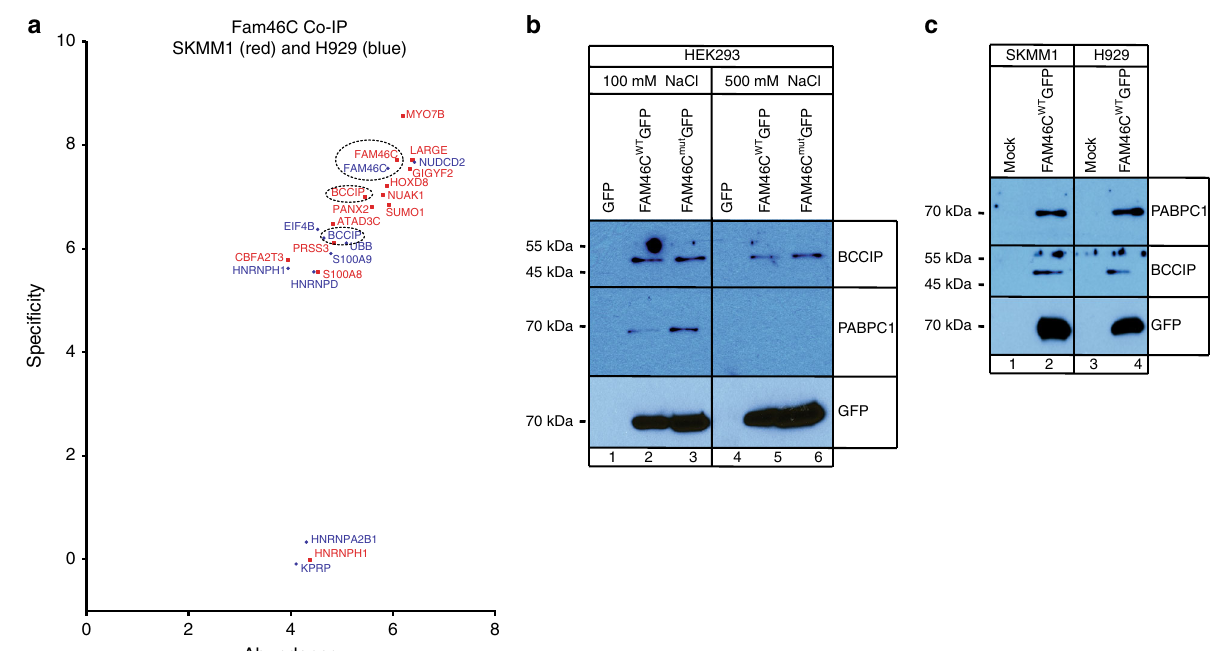
Fig. 9 FAM46C interacts with BCCIP β and PABPC1 in human cells. a Visualizations of Co-IP-MS experiments using GFP-tagged FAM46C expressed in myeloma cells H929 (shown in blue ) and SKMM1 (shown in red ). Estimated quantities of identi fi ed proteins were calculated using the label-free quanti fi cation (LFQ) algorithm and are represented as dot – plot graphs. Protein abundance was calculated as LFQ intensity of the protein signal divided by its molecular weight and is shown on the x axis on a logarithmic scale. Speci fi city was de fi ned as the ratio of protein LFQ intensity measured in the bait Co- IP to the background level (protein LFQ intensity in a sample) and is shown on the y axis on a logarithmic scale. b , c Western-blot detection of BCCIP β and PABPC1 co-immunoprecipitated with: b FAM46C WT -GFP and FAM46C mut -GFP from stable HEK293 cell lines; c FAM46C WT -GFP from transduced SKMM1 and H929 MM cell lines. Puri fi cation was performed at low (lanes 1 – 3) and high (lanes 4 – 6) ionic strengths. GFP-tagged FAM46C was detected with α -GFP antibodies. Please note that the lack of the GFP signal in the GFP only control (lanes 1 and 4) is because the blot was cutoff to avoid very strong GFP signal, which could in fl uence the